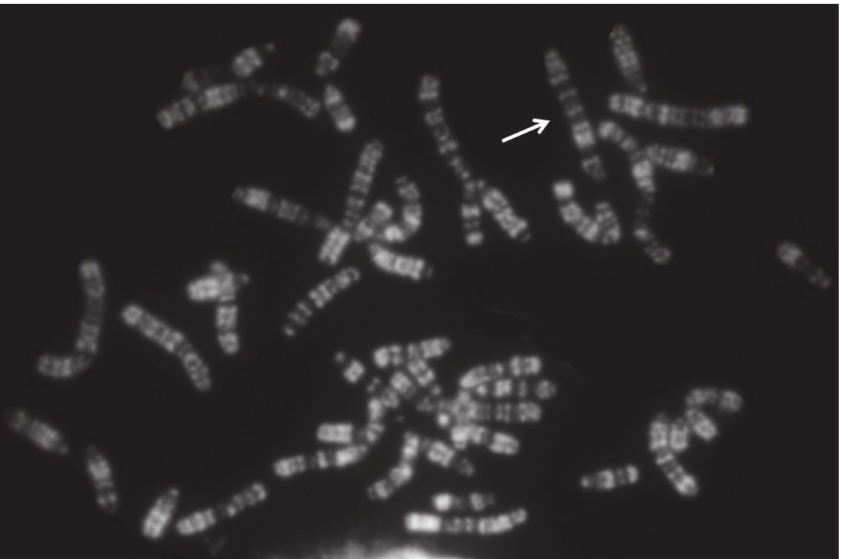
Figure 3. RBA-banding river buffalo metaphase from a female affected by X monosomy (2 n = 49,X). The only active X chromosome (arrow) was observed in all metaphases. This female was sterile due to damage to her internal sex